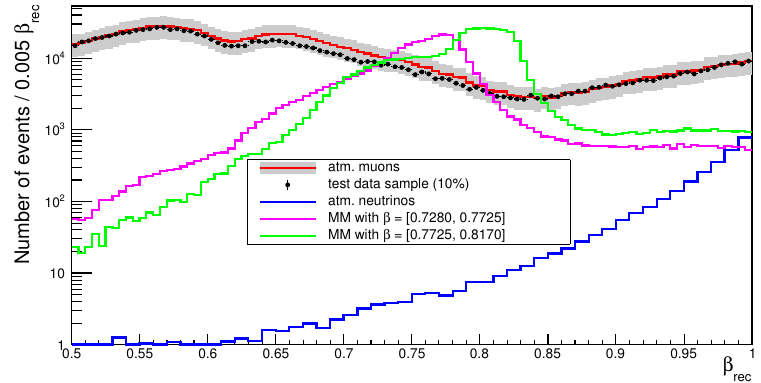
Figure 2 . The distribution of the reconstructed (cid:12) (cid:12)t for atmospheric muons (red histogram) with an uncertainty band of 35% ((cid:12)lled in gray), atmospheric neutrinos (blue histogram) and data (points with error bars). For comparison, the distributions of the reconstructed (cid:12) (cid:12)t for MMs simulated in the velocity ranges [0 : 7280 ; 0 : 7725] (magenta histogram) and [0 : 7725 ; 0 : 8170] (green histogram) are also shown. All distributions correspond to events reconstructed as